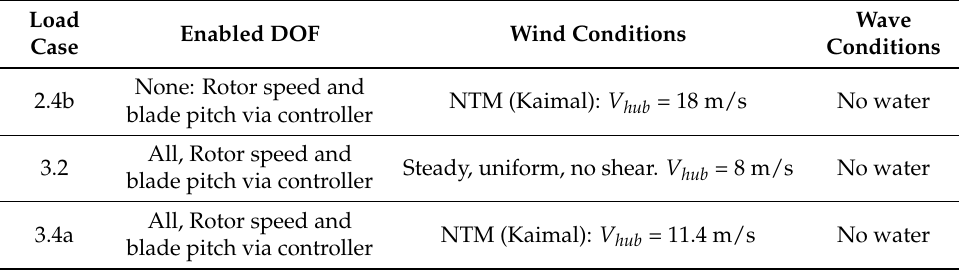
Table 6. Load Cases of OC4 Phase I for Jacket Substructure.